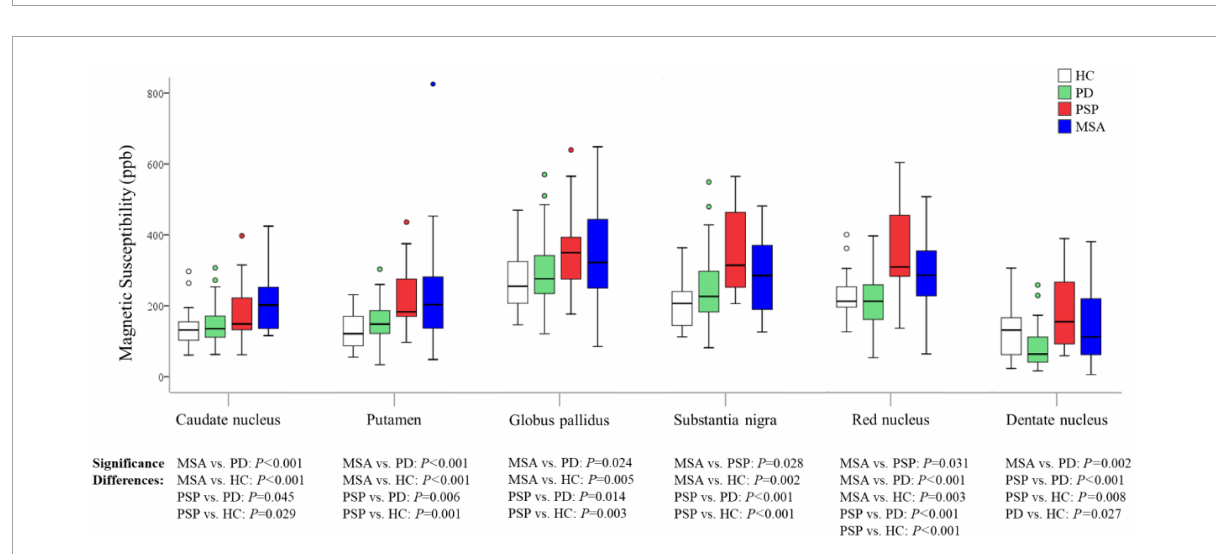
FIGURE2 Group comparisons of susceptibility values in the regions of interest. The P- values are corrected for multiple comparisons. HC, healthy control; PD, Parkinson’s disease; PSP, progressive supranuclear palsy; MSA, multiple system atrophy.